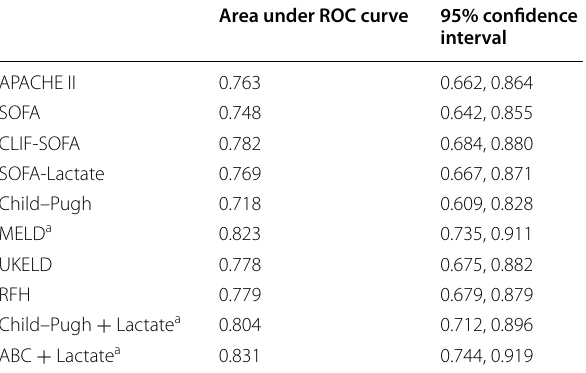
Table 4 Utility of scoring systems at predicting 12-month outcome in patients with cirrhosis admitted to ICU